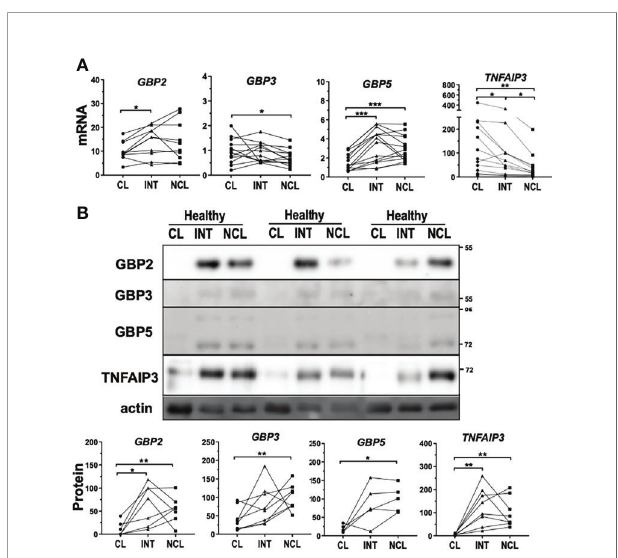
FIGURE 5 | Differential expression levels of genes regulating in fl ammasome activation between monocyte subpopulations. (A) mRNA expression and (B) protein levels of GBP2, 3 and 5 displayed downregulation in classical monocytes from healthy donors more signi fi cantly at protein level. TNFAIP3 had signi fi cantly higher mRNA expression in classical monocytes but TNFAIP3 protein levels were higher in both intermediate and non-classical monocytes; * comparison between subpopulations. *p < 0.05; **p ≤ 0.01; ***p ≤ 0.001.